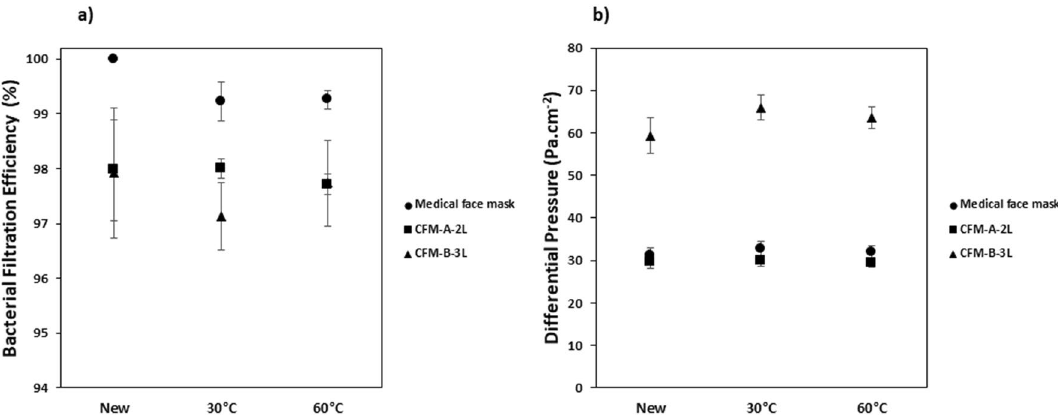
Figure 6. Influence of the wash temperature on ( a ) Bacterial Filtration Efficiency (%) and ( b ) Differential Pressure (Pa cm −2 ) for the medical face mask and the community face masks Average values (N = 5) ± standard-